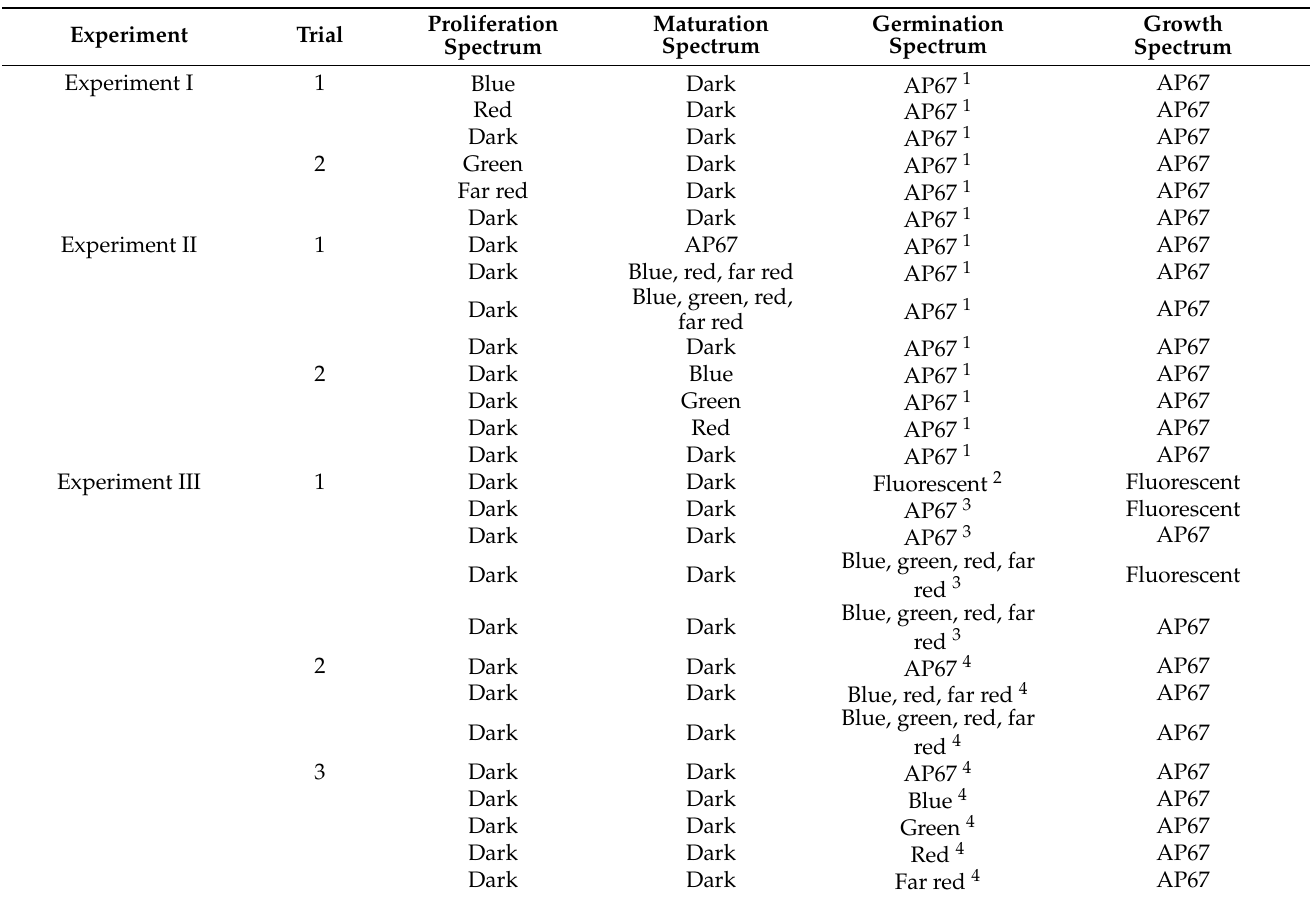
Maturation Germination Proliferation Growth Spectrum Spectrum Spectrum Spectrum